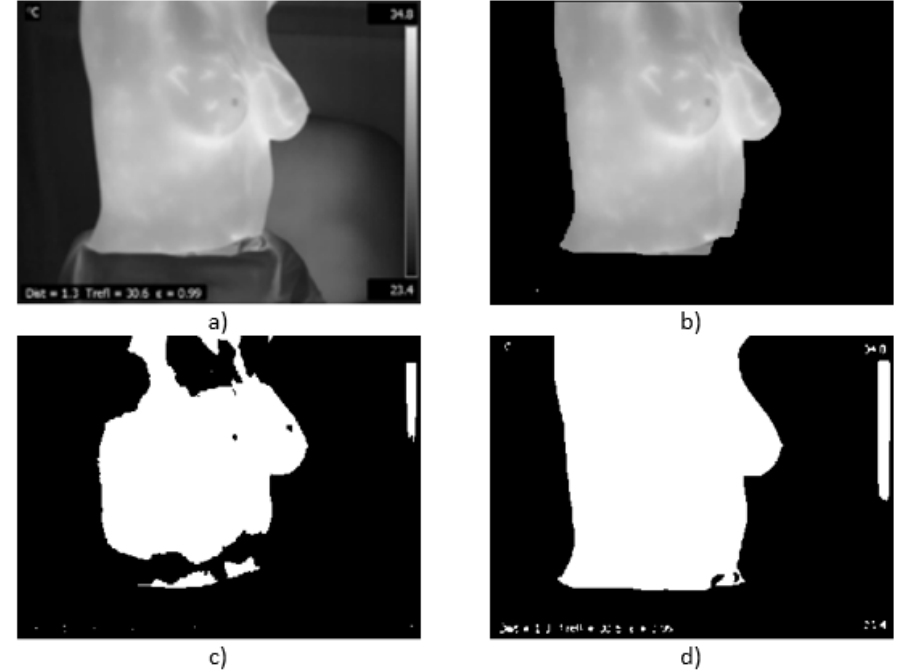
Figure 7. Patient segmentation from the background: ( a ) original thermogram in gray scale; ( b ) GrabCut method; ( c ) Hamadani’s method; and ( d ) Otsu’s